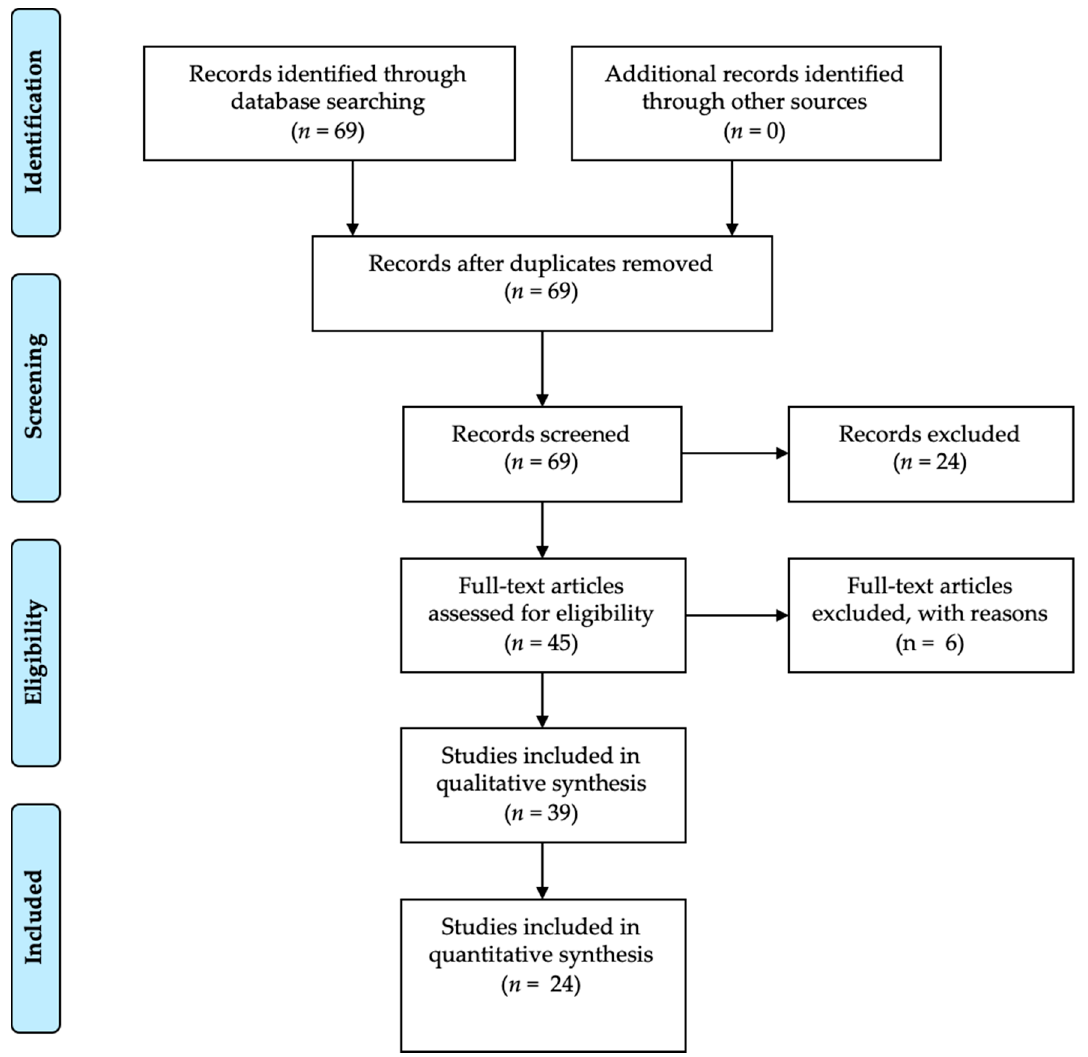
Figure 2. PRISMA flow chart.